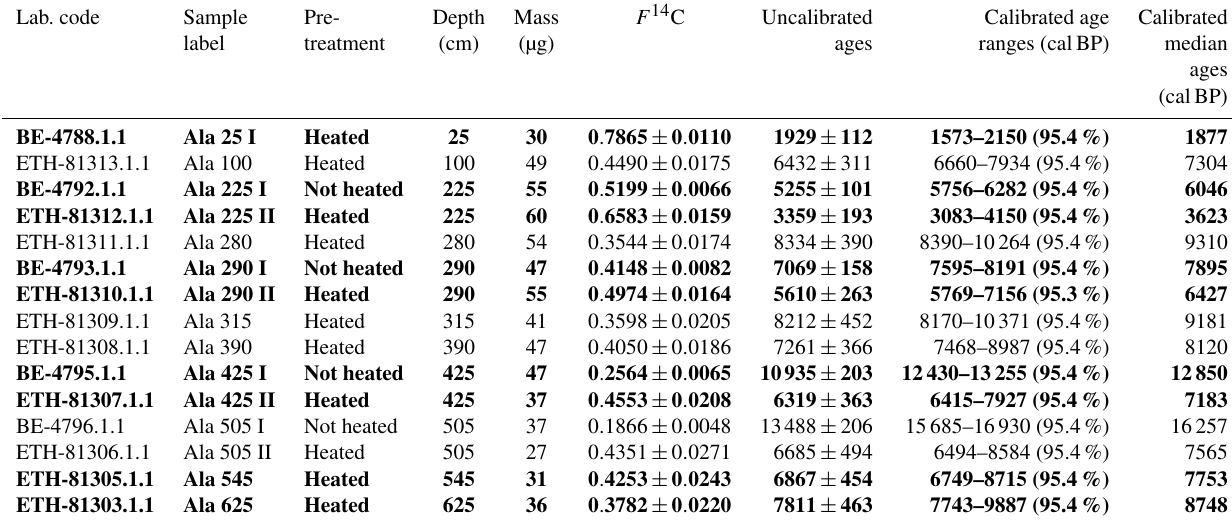
Table 1. n -Alkane 14 C ages from the investigated FSPS along the upper Alazani including treatment, carbon mass, fraction modern val- ues ( F 14 C), uncalibrated 14 C ages and calibrated 14 C ages as calibrated age ranges in calBP (95.4%) with the calibrated median age. The n -alkane samples from the pretest are marked with I, whereas the corresponding reanalyzed n -alkane samples are marked with II for direct comparison. Rows written in bold indicate n -alkane samples from